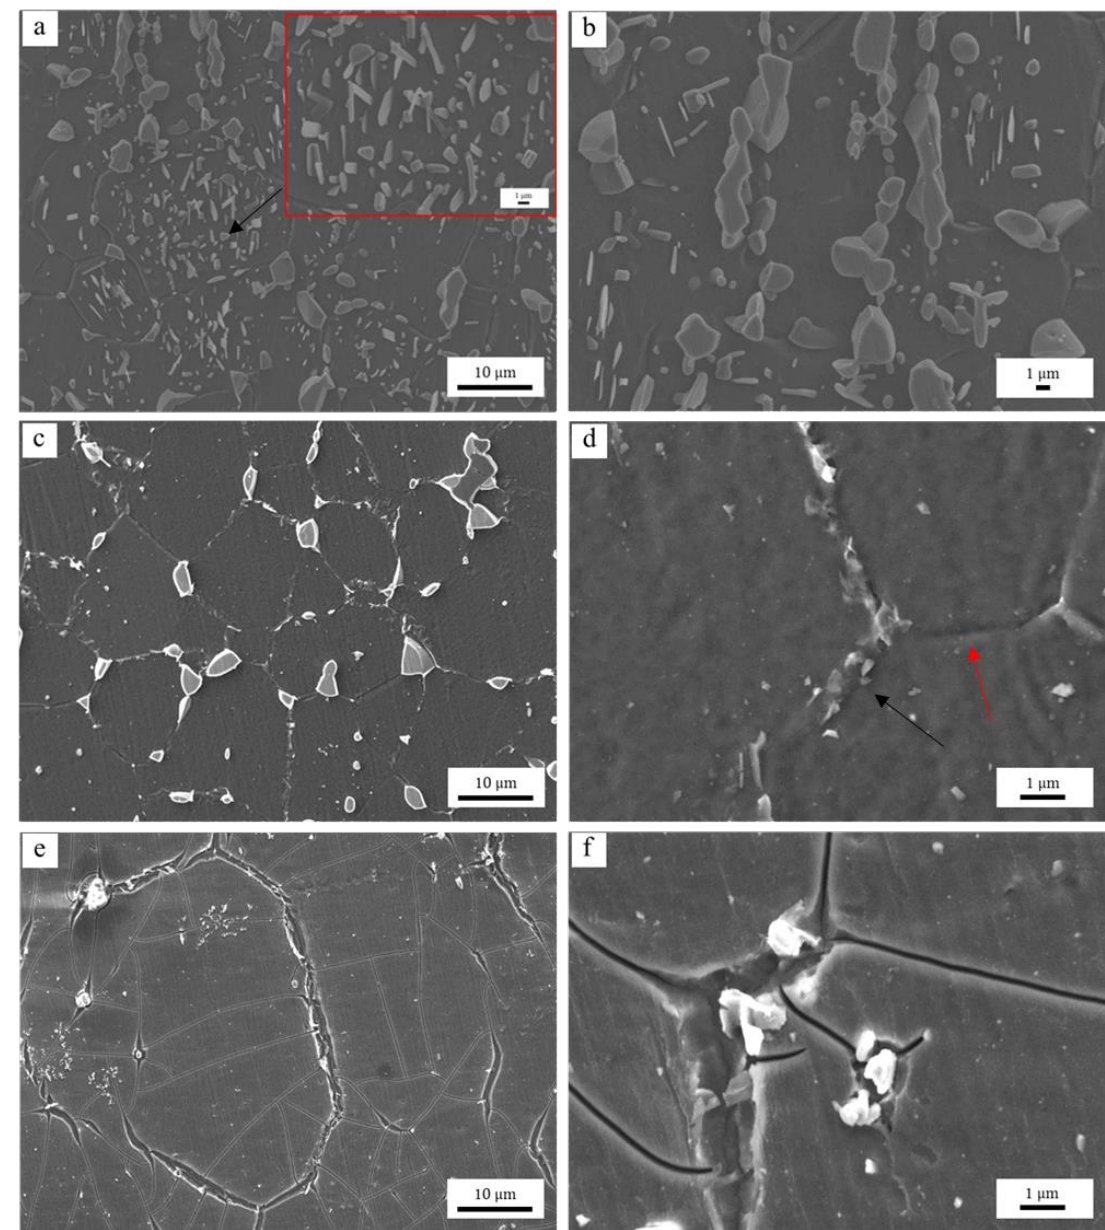
Figure 13. SEM images of AZ91 annealed at ( a , b ) 300 °C, ( c , d ) 350 °C, and ( e , f ) 400 °C for 72 h. The red rectangle in ( a ) is an enlarged view of the second phase particles within the grain shown by the black arrow. The red and black arrows represent the distribution of second phase particles at different grain boundaries